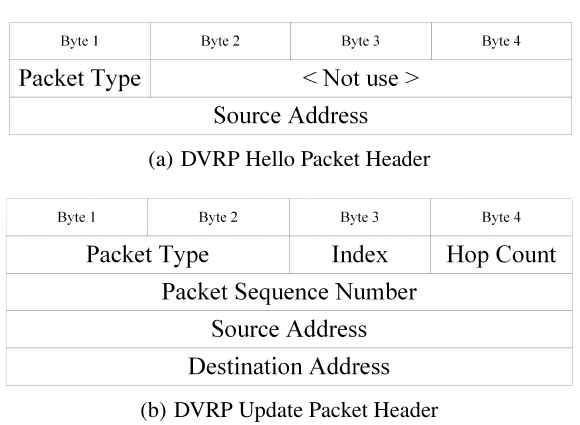
Figure 2: Routing Packet Headers